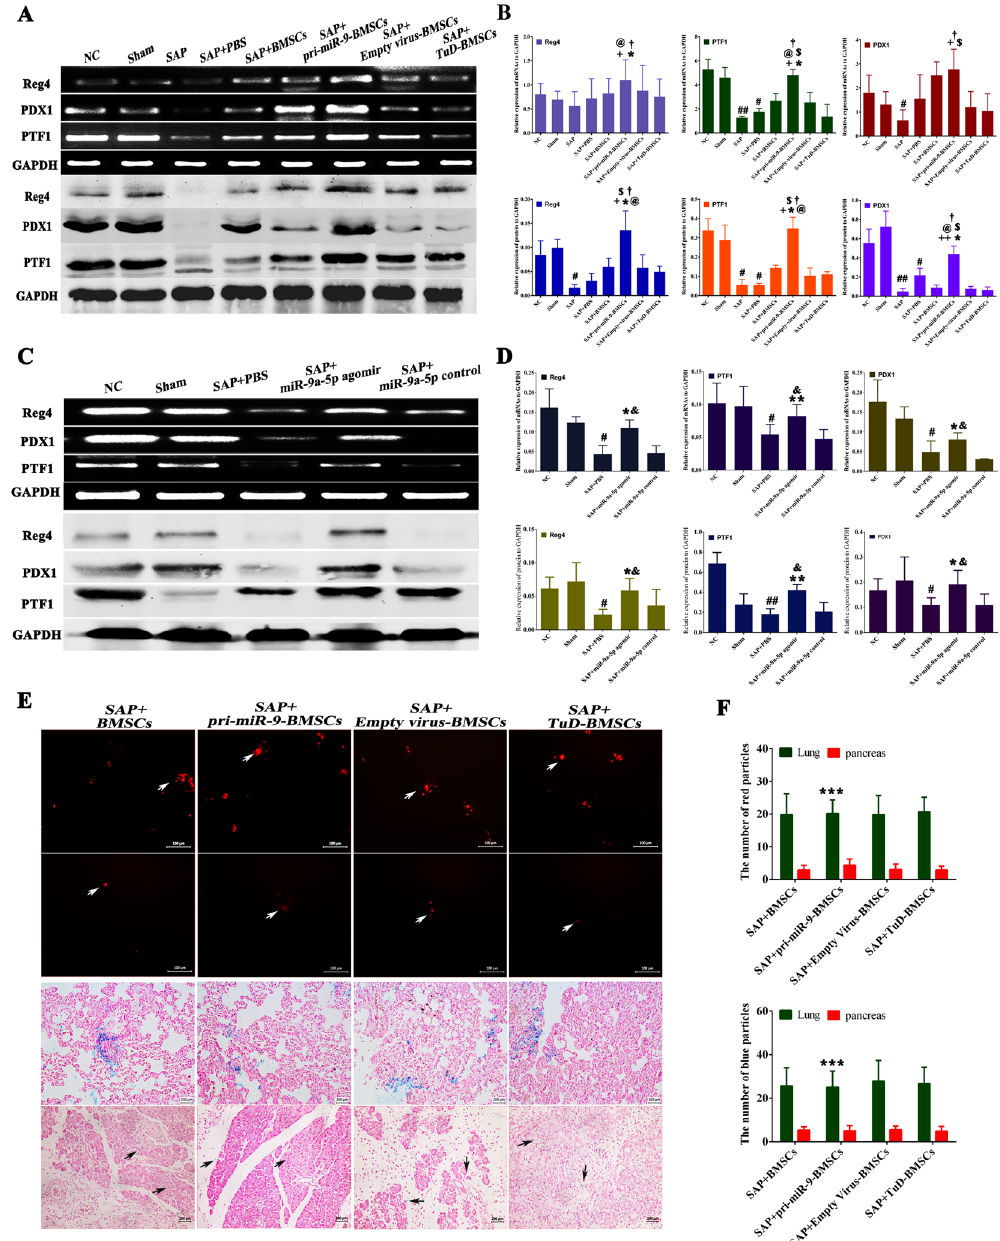
Figure 5. pri-miR-9-BMSCs and miR-9a-5p agomir promote the regeneration of damaged pancreas mainly depending on the paracrine. The expressions of pancreatic regenerative proteins (Reg4, PTF1, and PDX1) were significantly promoted by pri-miR-9-BMSCs ( A,B ) or miR-9a-5p agomir ( C,D ), compared with SAP, SAP + PBS, BMSCs, TuD-BMSCs, or miR-9a-5p control groups. Data are shown as mean ± SD for at least 3 separate experiments. # p < 0.05 and ## p < 0.01, compared with NC, + p < 0.05, compared with SAP, * p < 0.05 and ** p < 0.01, compared with SAP + PBS, @ p < 0.01, compared with BMSCs, $ p < 0.05, compared with Empty virus-BMSCs, † p < 0.05 and †† p < 0.01, compared with TuD-BMSCs, & p < 0.05, compared with miR- 9a-5p control group. (E,F ) The distributions of CM-Dil- and SPION- labeled BMSCs in vivo were observed by the fluorescence microscope and Prussian blue staining respectively. The number of cells migrating to the damaged pancreas had no difference among BMSCs, pri-miR-9-BMSCs, Empty-virus-BMSCs and TuD-BMSCs groups, but less than those of migrating to lung at day 3 after transplantation. Data are shown as mean ± SD. *** p < 0.001, compared with pancreas by using two-tailed t test. SPION, Superparamagnetic Iron Oxide